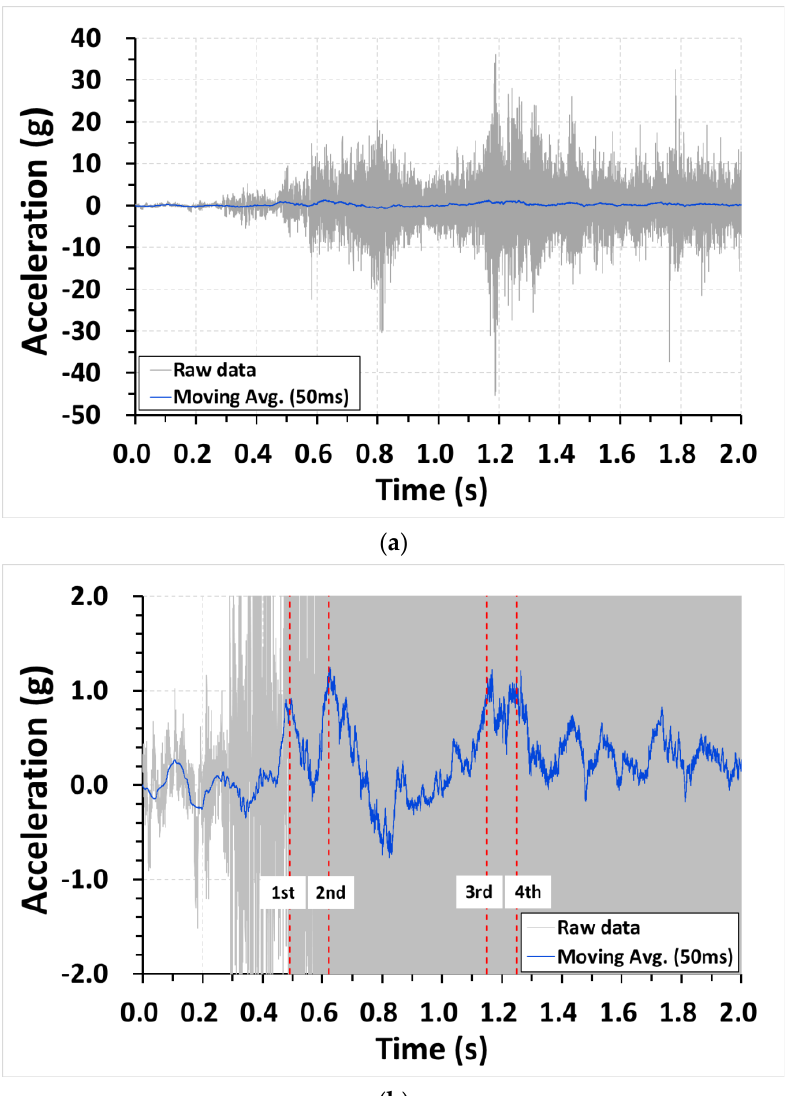
Figure 12. Lateral acceleration of the flat wagon: ( a ) raw and filtering data and ( b ) the point at which the wheels collided with the DCP.